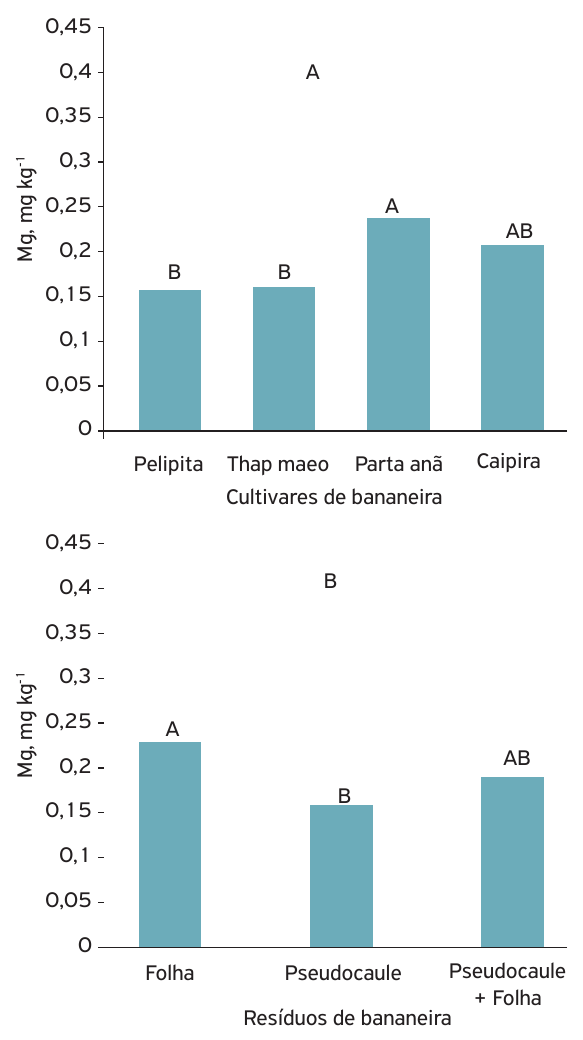
Figura 11. Teores de Mg, %, presente no substrato à base de resíduos (pseudocaule, folha e pseudocaule + folha) (A) de quatro cultivares de bananeira (Thap maeo, Prata anã, Pelipita e Caipira) (B) antes da sua colonização pela linhagem 09/100 de Pleurotus ostreatus . Letras maiúsculas comparam médias dentro de um